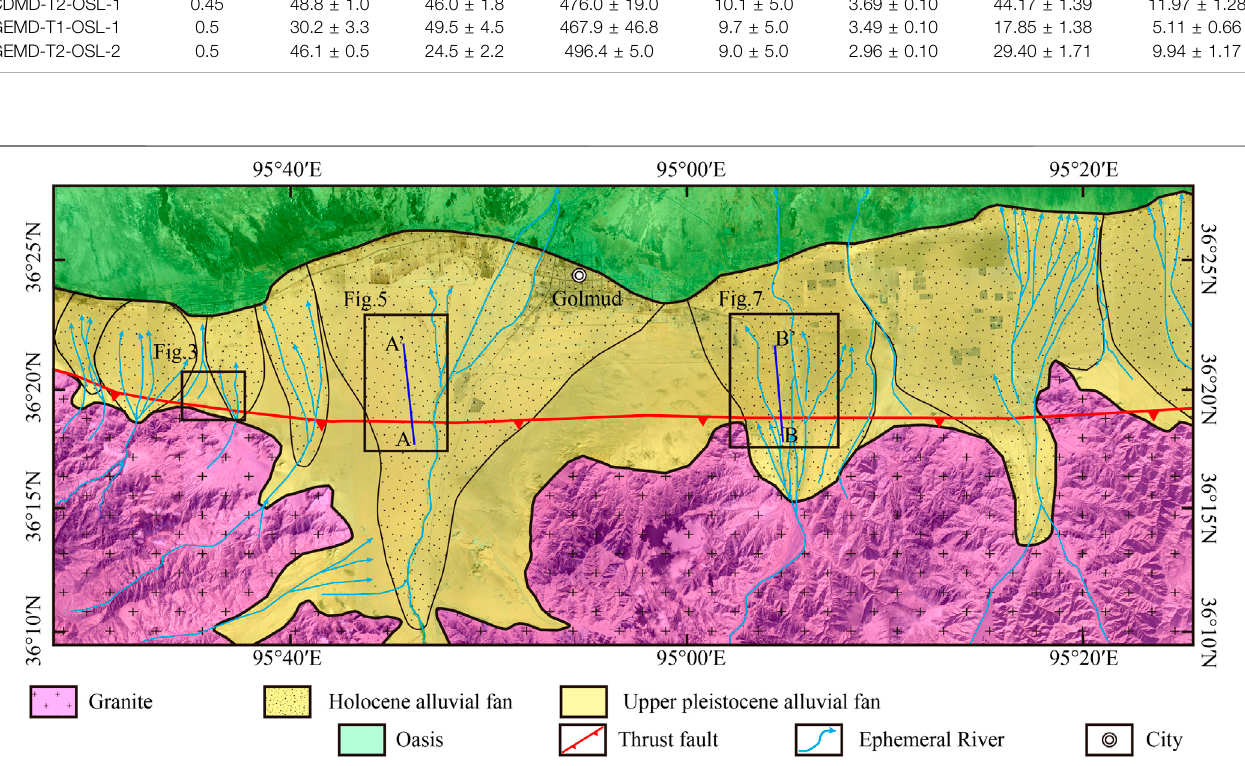
Frontiers in Earth Science |